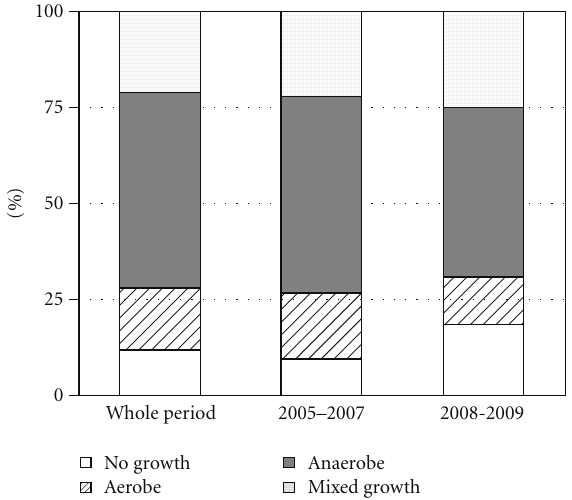
Figure 1: Results of bacteriological study for whole period, period between 2005 and 2007, and period between 2008 and 2009. Results of bacterial culture were classified as no growth, aerobes only, anaerobes only, and mixed growth of aerobes and